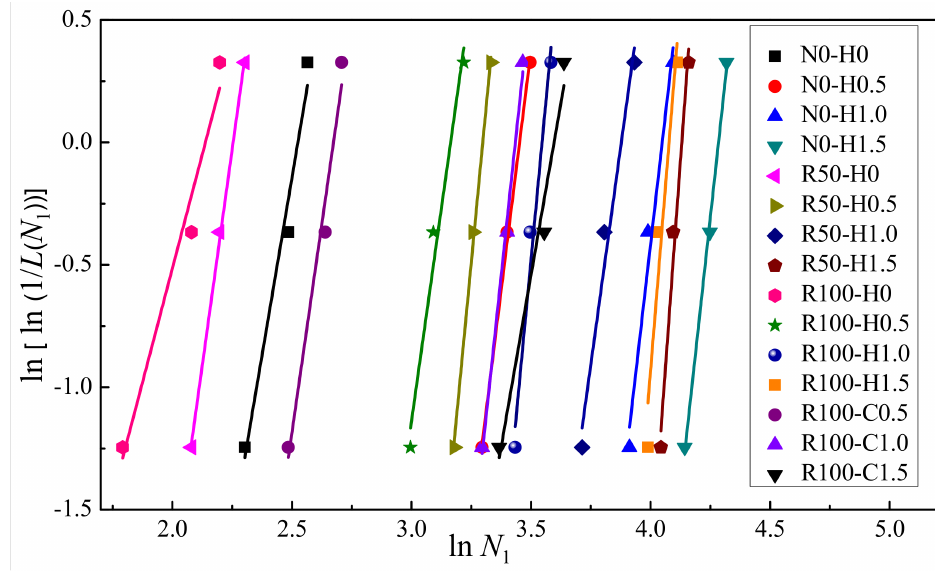
Figure 11. Linear regression of N 1 in Weibull distribution.